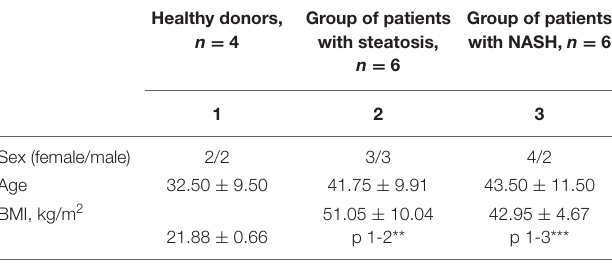
TABLE 1 | Characteristics of patients in the study.